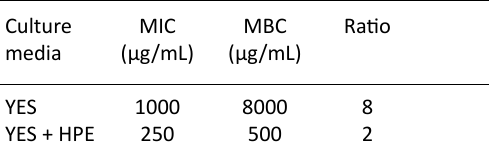
Table 2. Minimal inhibition concentration (MIC) and Minimal bactericidal concentration (MBC) values of the extracts against MRSA ATCC33591 Culture